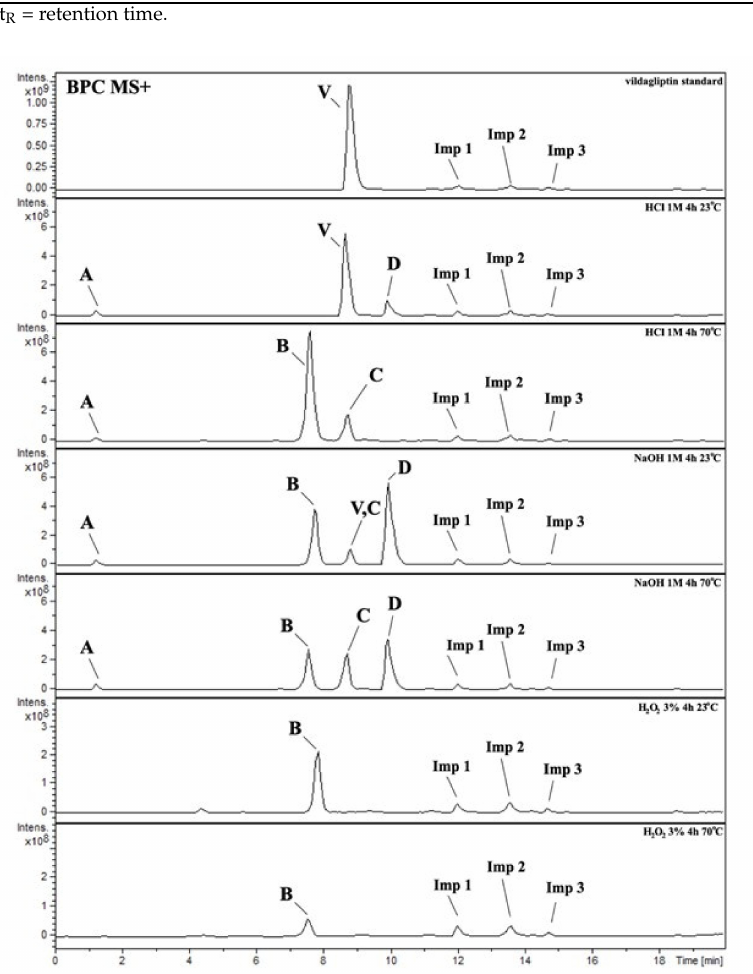
Figure 4. BPC MS+ chromatograms of the analyzed samples. V=vildagliptin, A, B, C, D = Compounds A–D (degradation products of vildagliptin) and Imps